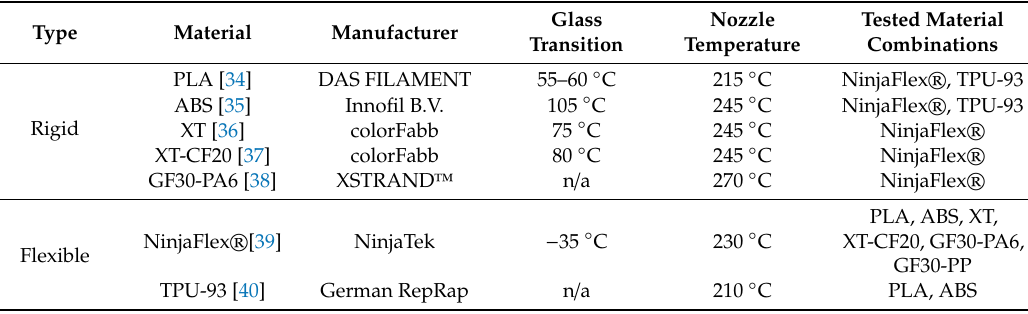
Table 1. Selective material properties and utilized process parameters for the manufacturing of the multi-material test specimens.